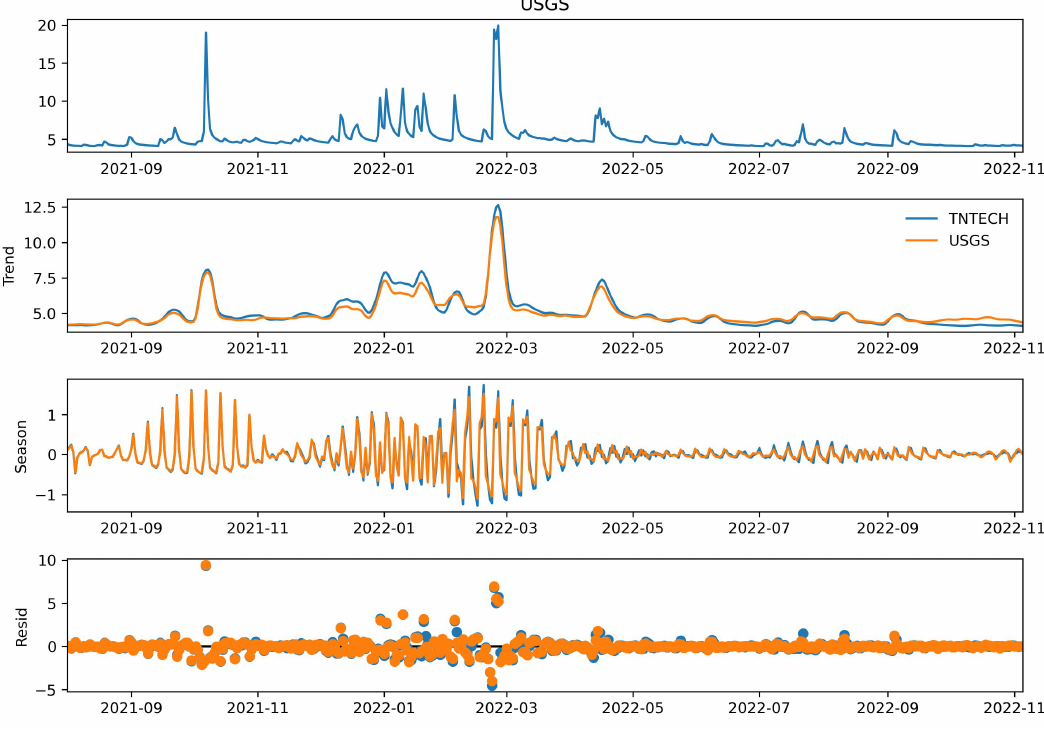
Figure 8. Comparison of the time series components using Loess Seasonal